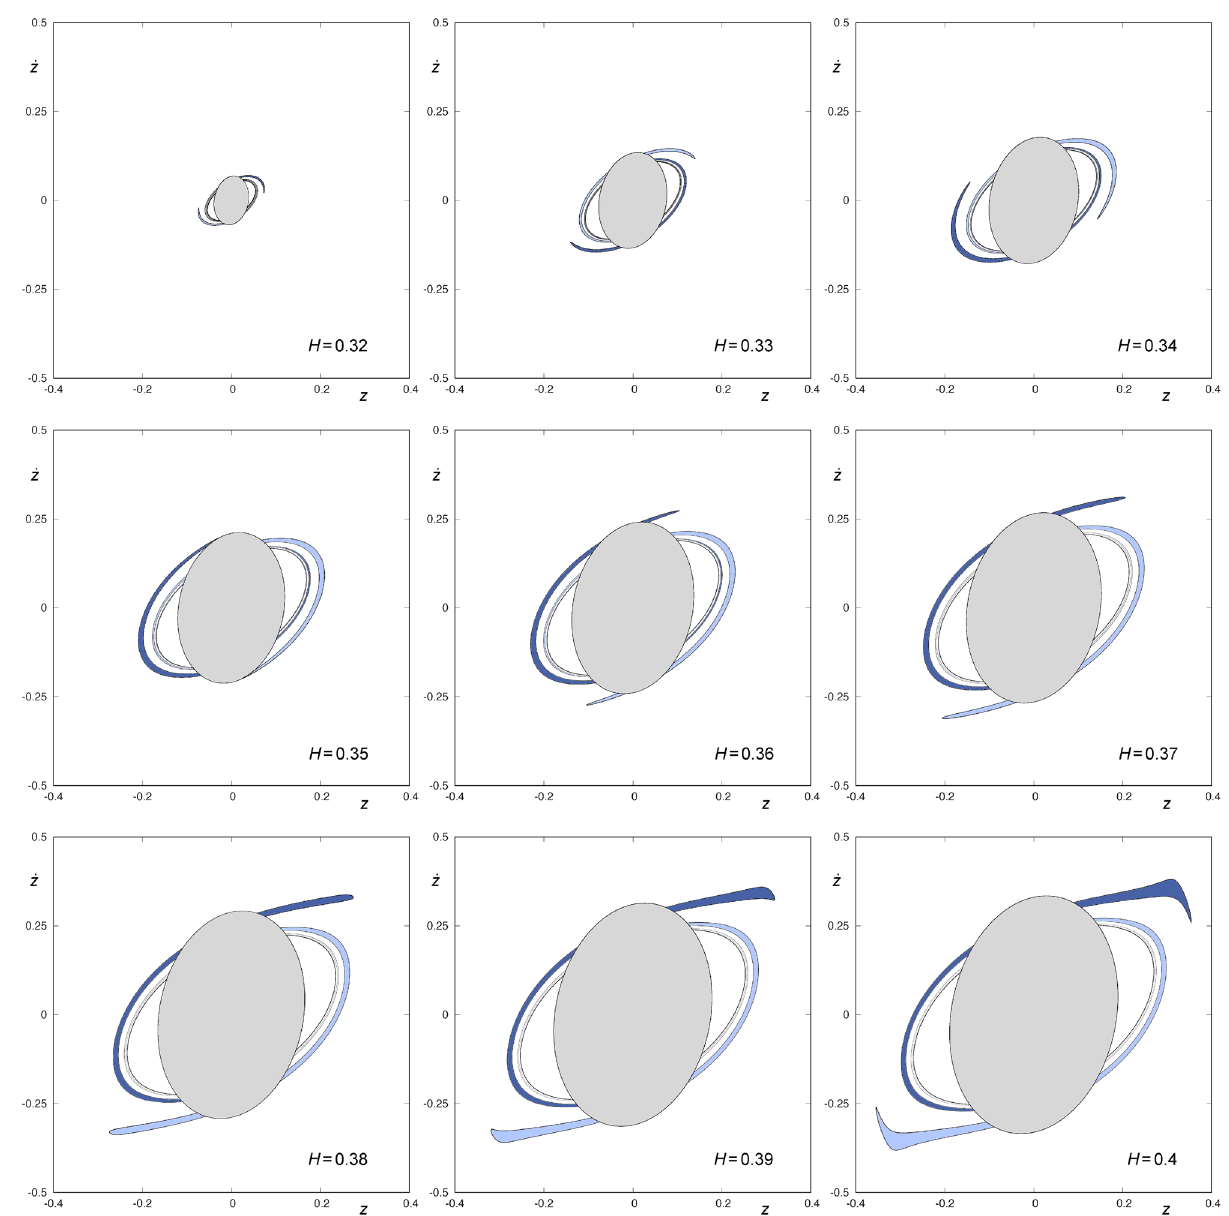
Figure 5. W s ,4 (φ) and W u ,1 (φ) for H = H 0 + n (cid:31) H , where H 0 = 0.32 , (cid:31) H = 0.01 and 0 ≤ n ≤ 8 . Orbits starting in the area enclosed by W u ,1 (φ) are colored in light grey. Orbits with initial conditions belonging to the area enclosed by W s ,4 (φ) and outside the area enclosed by W u ,1 (φ) are colored in blue. This graphic has been generated by using Gnuplot Version 5.2. http:// www. gnupl ot. We observe this same phenomenon for values of H in a neighborhood of H = 0.35 . In Fig. 7, we show a detail of W s ,4 (φ) and W u ,1 (φ) , for values of the energy given by H = 0.347 , 0.349, 0.351 and 0.354. In the upper-left panel of Fig. 7, we can observe that the tip of one of the tongues belonging to W s ,4 (φ) , colored in dark blue, is not contained in the region defined by W u ,1 (φ) , when H = 0.347 . If we examine the evolution of the tongues as the energy grows, we find that there exists a value H α ,1 of the energy, slightly larger than H = 0.349 , such that the tip of each of the infinite tongues that make up W s ,4 (φ) is tangent to W u ,1 (φ) , that is, the tip of each tongue intersects W u ,1 (φ) at just one point. In the upper-right panel of Fig. 7, we observe how the tip of one of the tongues belonging to W s ,4 (φ) , colored in dark blue, is very close to be tangent to W u ,1 (φ) . If the value of the energy is slightly increased over H α ,1 , the tip of each tongue belonging to W s ,4 (φ) enters the region enclosed by W u ,1 (φ) , as depicted in the lower-left panel of Fig. 7. There is a value H α ,2 of the energy, barely smaller than W u H = 0.351 , such that the tip of each tongue of W s ,4 (φ) , now contained in the area enclosed by ,1 (φ) , is tangent to W u ,1 (φ) at one point. For values of H slightly larger than H α ,2 , the tip of each tongue belonging to W s ,4 (φ) goes out of the region defined by W u ,1 (φ) , as we can observe in the lower-right panel of Fig. 7. Therefore, for values of the energy in the interval I α = ( H α ,1 , H α ,2 ) , the tip of each tongue belonging to W s ,4 (φ) is contained